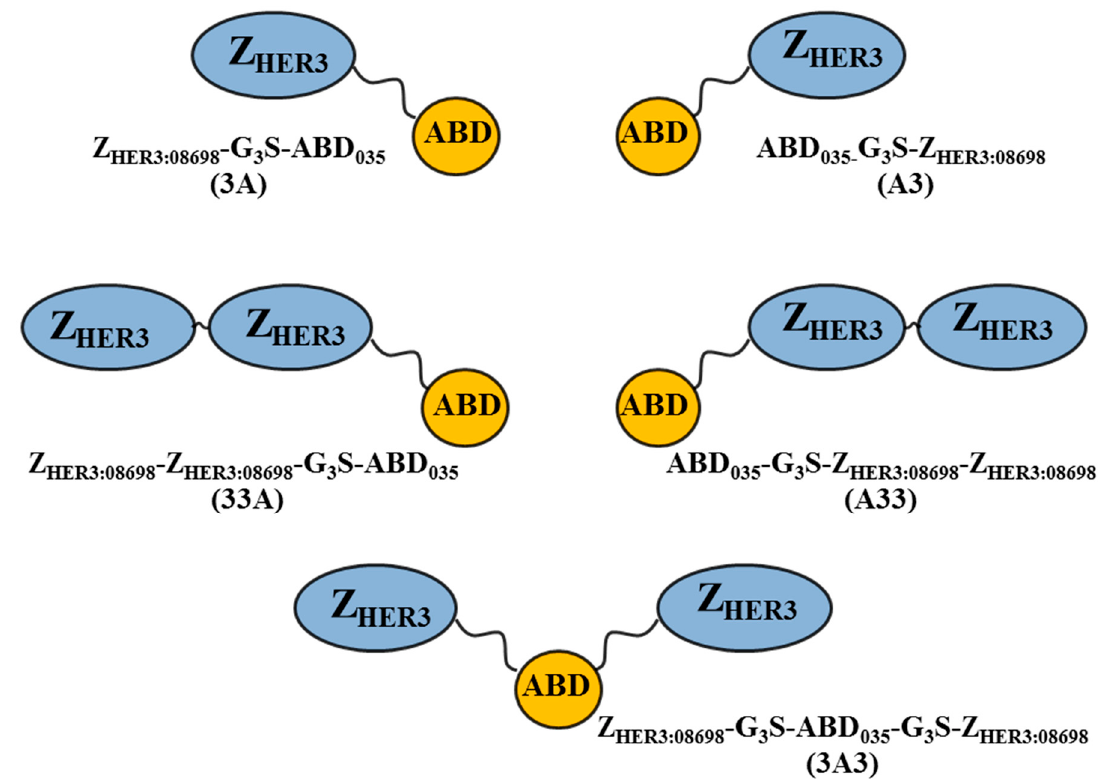
Figure 1. Schematic representation of anti-HER3 affibody molecules flanking ABD with different orientations. ABD: albumin-binding domain; HER3: human epidermal growth factor receptor type 3.